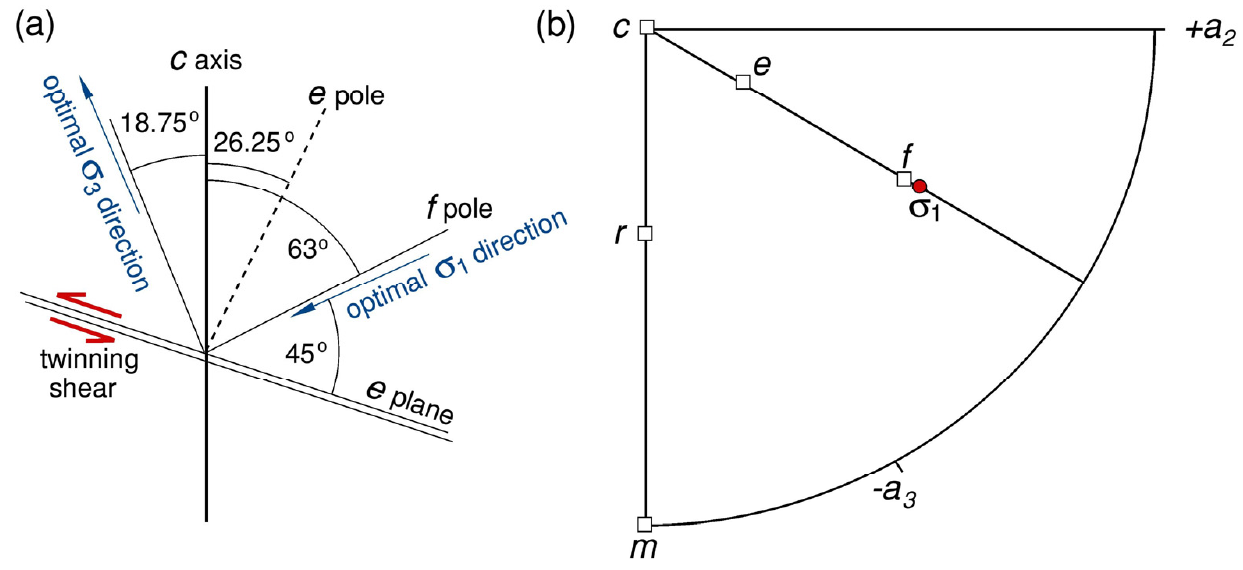
Figure 6. ( a ) The crystallographic zone containing poles to e and f , the calcite c -axis and the slip vector for twinning (which lies on the e -plane), to show angular relations. e -twinning can only occur with the shear sense shown, thus the optimal orientation of σ 1 for twinning lies on the zone plane at 45 ◦ to the e -pole, close to the f -pole; ( b ) Upper hemisphere equal-area projection of calcite showing the relations between c ‐ and a ‐ axes, and the poles to planes e , f and the trigonal prism m . The position σ 1 in the optimal orientation for twinning is shown.